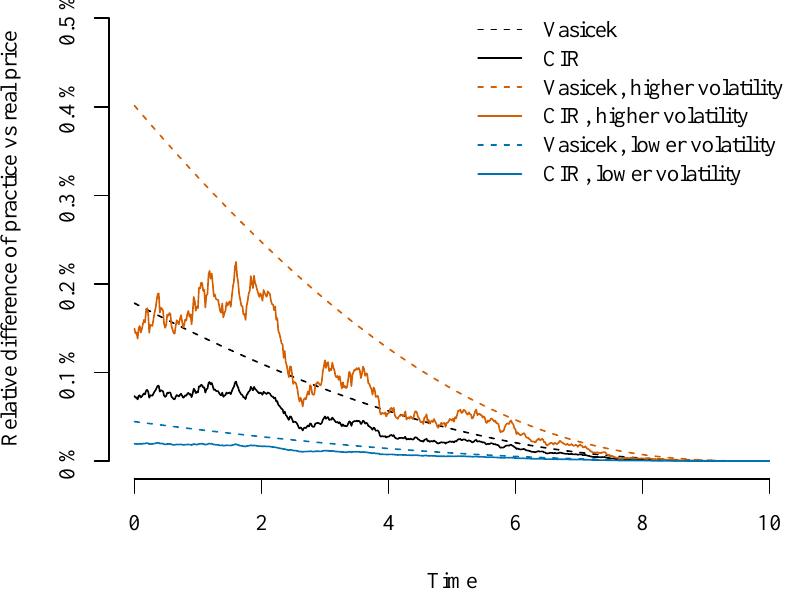
Figure 5. Difference between the approximation based on the forward interest rate curve and the correct theoretical prices in the Vasicek and CIR models. The Vasicek and CIR models with parameters from Table 1 are shown, as well as two variations, where the volatilities are scaled up respectively down by 50%. The approximated value overestimates the correct value by 0.01–0.4% in our numerical